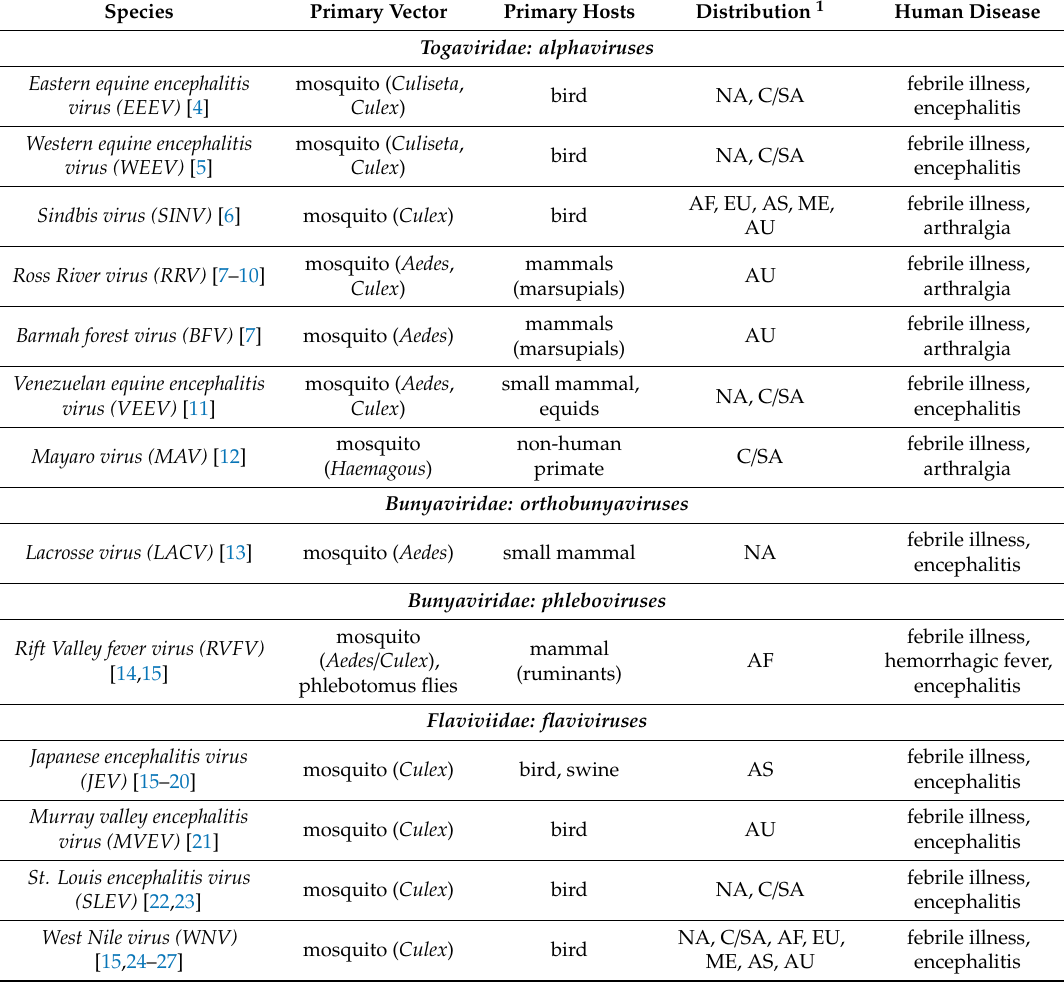
Table 1. Zoonotic mosquito-borne viruses commonly associated with human